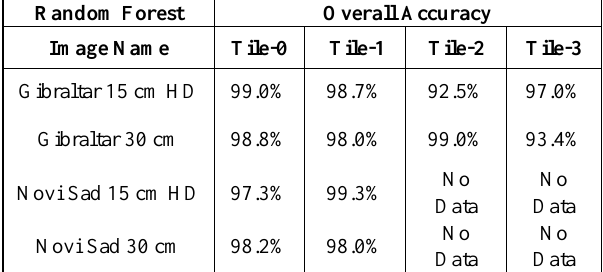
Figure 8. The RF classification result of Novi Sad Serbia MAXAR HD image.